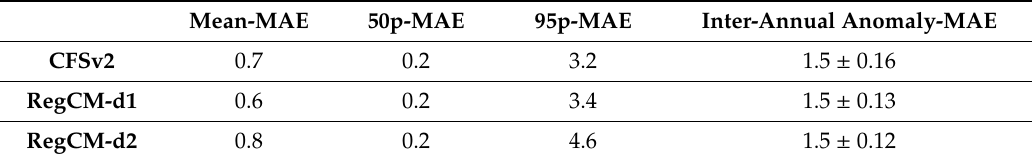
Table 2. Mean absolute error (MAE) for daily accumulated precipitation climatological period, 50th and 95th percentiles, and inter-annual anomaly variability for the three SFSs compared to the reanalysis. In the rightmost column the standard represents the ensemble spread from the ensemble mean anomaly MAE. The four metrics are averaged over the winter season. Units are mm / day. See text for